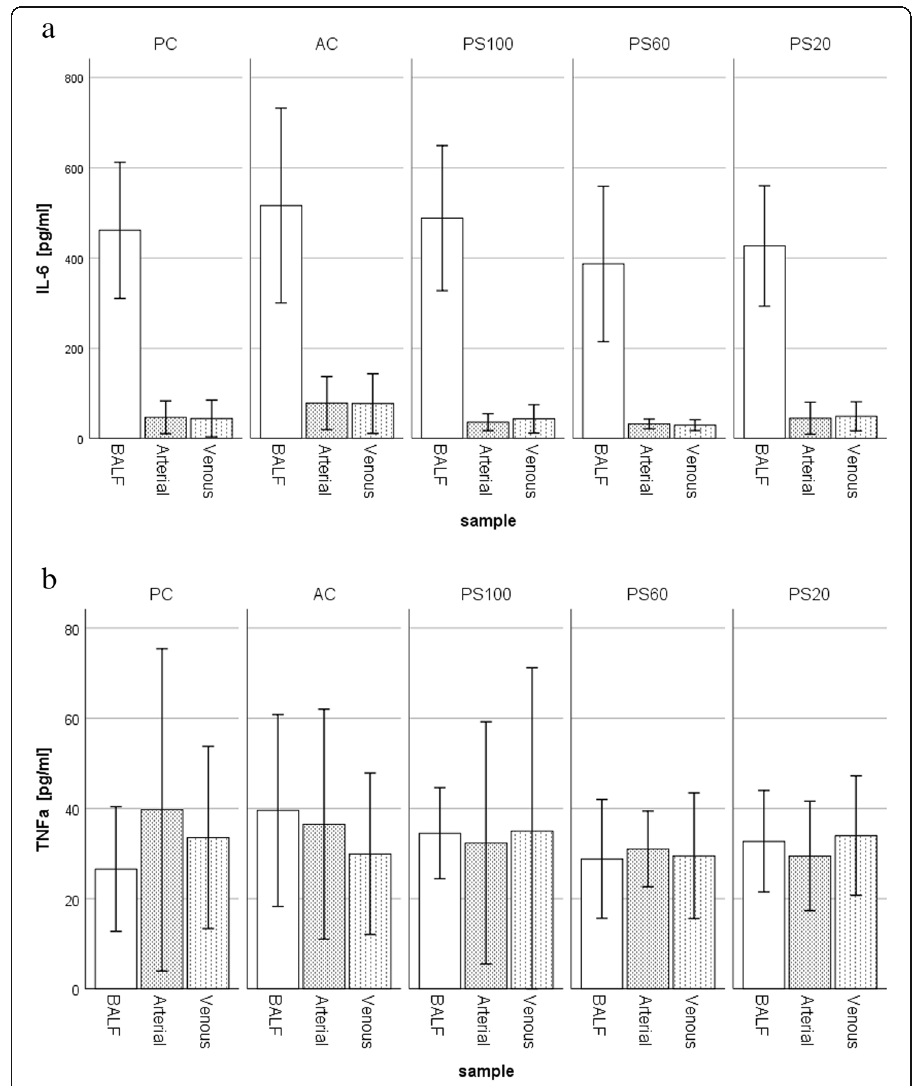
Fig. 3 Measurement of cytokines in the bronchoalveolar fluid (BALF) and arterial (Art) and venous (Ven) samples. Data are presented as mean ± SD [pg/ml], upper panel ( a ): IL6. Measured levels were higher in the BALF than the plasma, but differences among groups were not statistically significant; lower panel ( b ): TNF- a. No significant differences were found between BALF and plasma or among